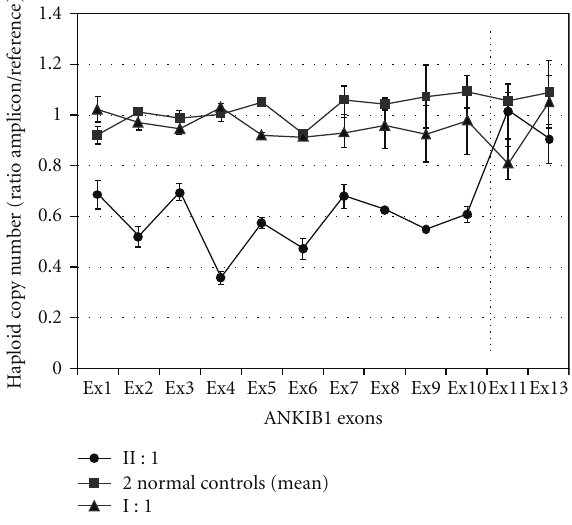
Figure 4: ANKIB1 gene breakpoint determination by RT-QPCR ( ± standard error mean). Results from normal genomic DNA (2 normal controls mean), from the una ff ected member of family (I:1 sample), and in one a ff ected members (II:1) are visualized by a closed triangle ( (cid:2) ), a closed square ( (cid:3) ), and a closed circle ( • ), respectively. The ANKIB1 exons on the left of the vertical dotted lines (exon1–10) show the copy number loss of the associated